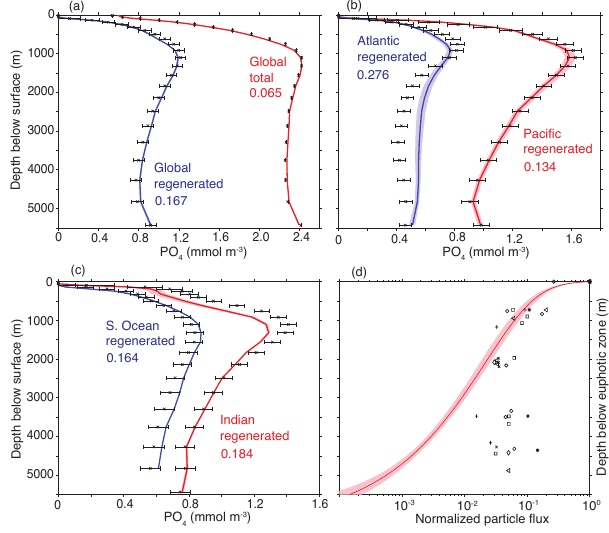
Figure 5. (a) Globally averaged depth profile of total PO 4 (red curve) and regenerated PO 4 ( r PO 4 , blue curve), for the CTL model and the observations (black x + error bars). (b) Modeled (curves plus shading indicating uncertainty) and observed (black x + error bars) r PO 4 averaged over the Pacific (red) and Atlantic (blue) oceans. (c) Same as (b) for the Indian (red) and Southern (blue) oceans. (d) Modeled particle flux profile (red curve plus shading in- dicating uncertainty) for (cid:15) = 4 . 2, and observed particle fluxes from sediments traps in the equatorial Pacific (symbols). Printed on (a– c) is the normalized root mean squared error (RMSE divided by the average PO 4 or r PO 4 concentration) for the CTL model for the region and data type